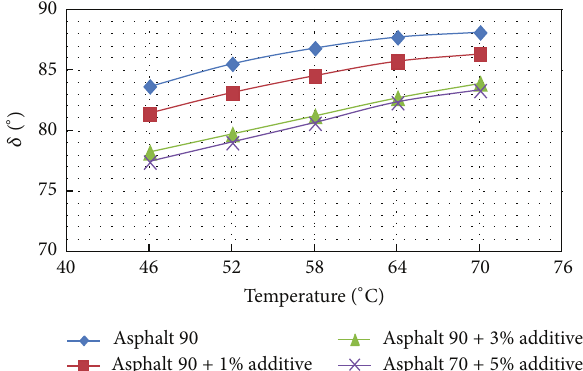
Figure 4: Phase angles of 90# virgin asphalt and WMA binder versus temperature.